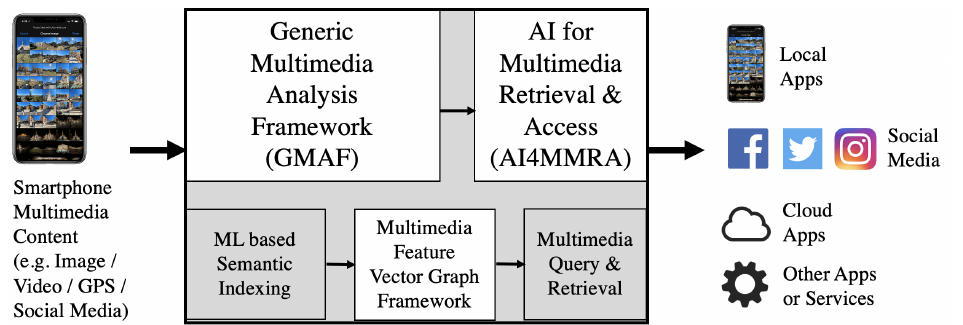
Figure 3. Multimedia asset management system architecture including the generic multimedia analysis framework (GMAF), multimedia feature vector graph (MMFVG) and AI for multimedia retrieval and access